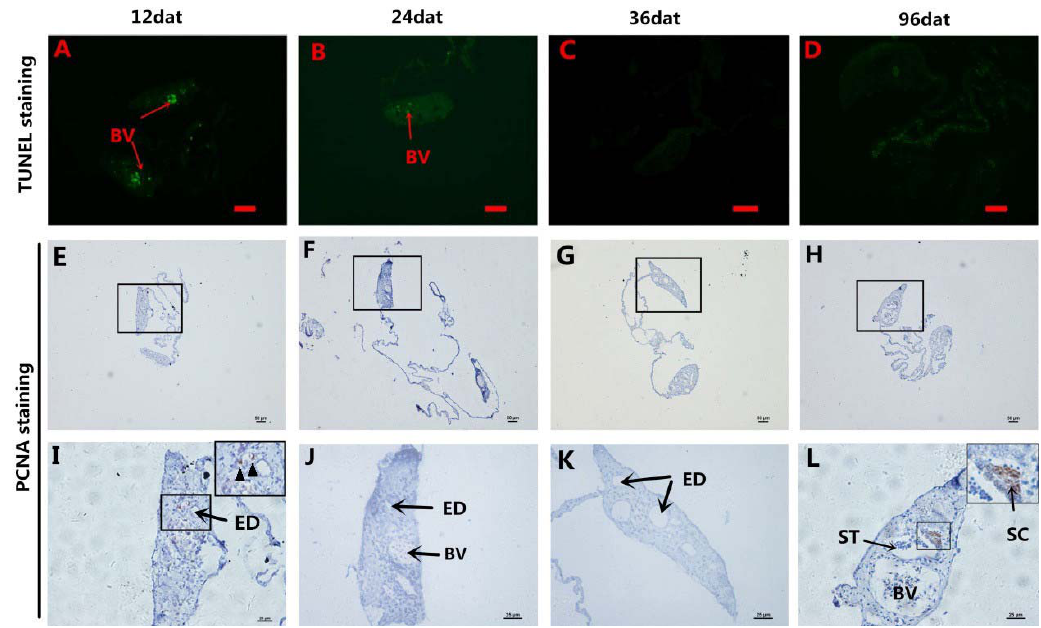
Figure 5. TdT-mediated dUTP nick end labeling (TUNEL) assay and Proliferating cell nuclear antigen (PCNA) staining. ( A – D ) TUNEL staining of gonad sections during MT-induced sex reversal. No TUNEL positive signals were detected in the 12 to 96 dat gonads tissues except in blood vessels ( A – D ). ( E – L ) The PCNA staining of gonad sections during MT-induced sex reversal. ( E – H ): High magnification of the boxed areas in ( I – L ). PCNA-positive signals were detected in somatic cells around the efferent dust (black arrowheads) in 12 dat gonad ( E , I ) and the SC in 96 dat gonad ( H , L ). BV: blood vessels; ED: efferent dust; SC: spermatocytes; ST: spermatids; Scale bars, 25 μ m.